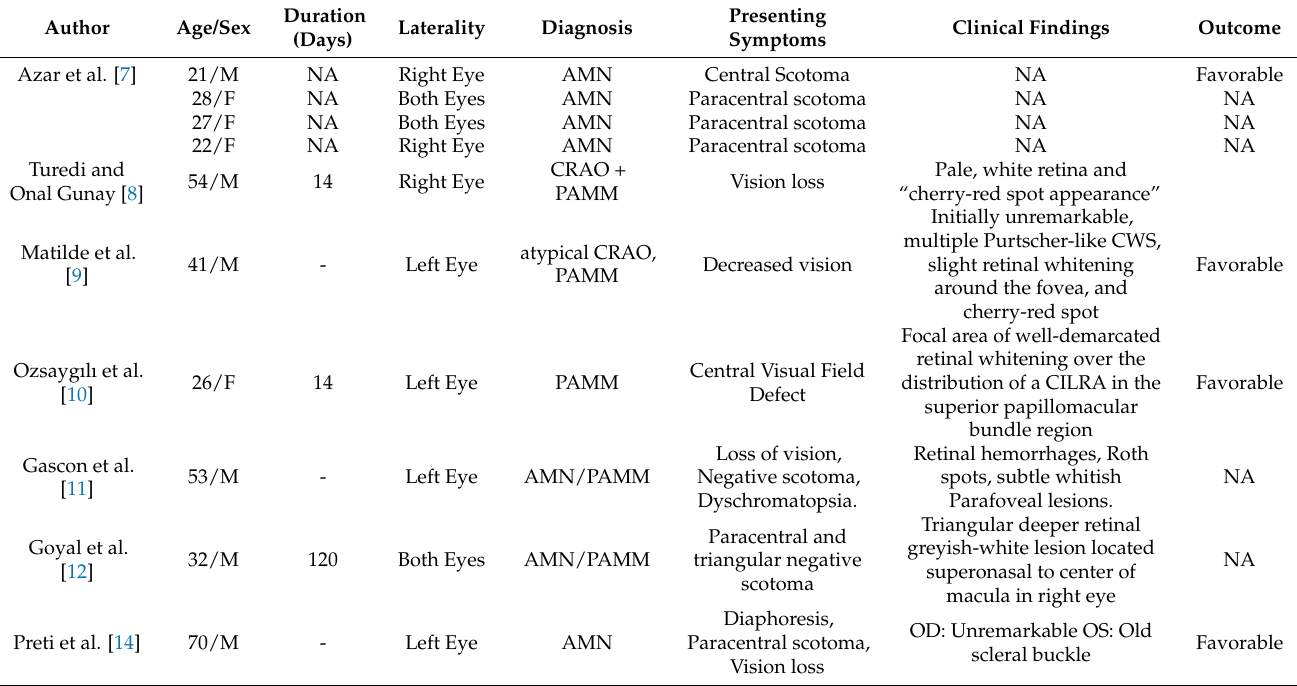
Table 1. Review of Literature of AMN and PAMM cases in COVID-19